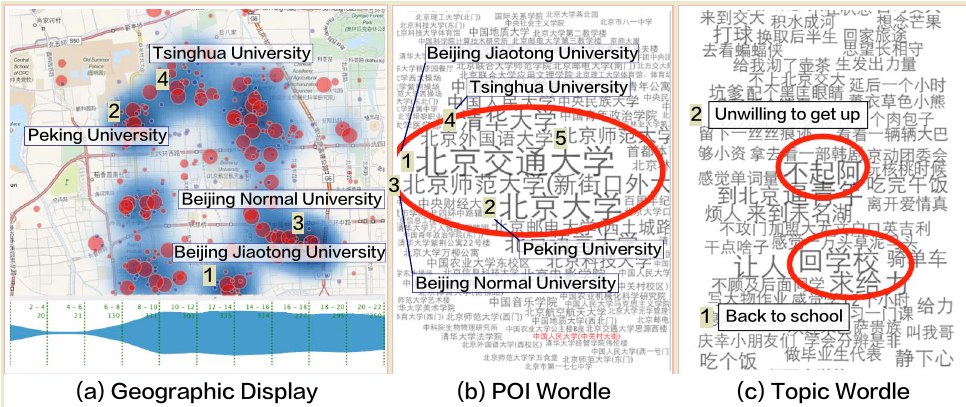
Figure 11. College Students Check-in Records Exploration. ( a ) The geographic display shows the heatmap distribution of check-in records generated by students in Beijing and five universities contributed most check-in records extracted by interaction in POI Wordle view and marked on the map; ( b ) Five universities ranks top five in the records are marked by red circle. The size of each word representing different universities encodes the number of records found in that campus. The top five campus listed in records number order are: (1) Beijiing Jiaotong University; (2) Peking University; (3) Beijing Normal University; (4) Tsinghua University; and (5) Beijing Foreign Studies University; ( c ) The content extracted from users’ original post records. The size of each phrase encodes how many users sharing the idea or action. The top two posts’ keywords shared by most students on campus when semester starts are: (1) Back to school; (2) Unwilling to get